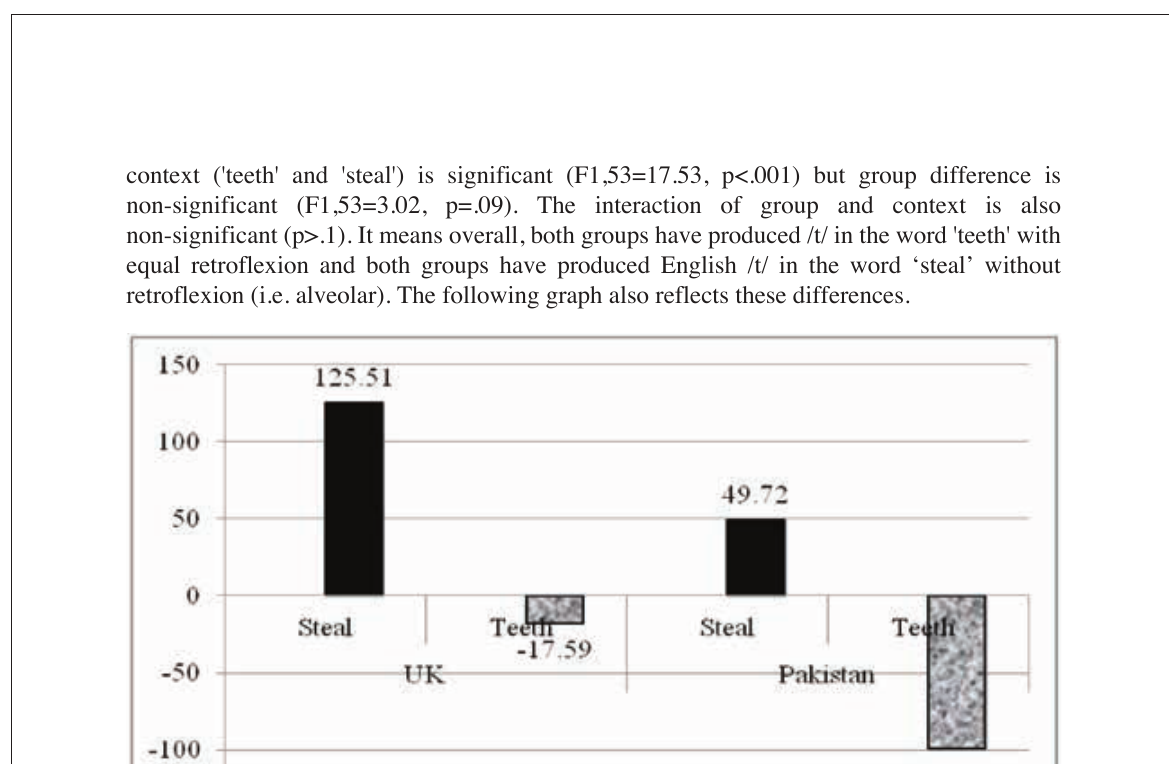
Figure 2: F3 lowering/raising in the